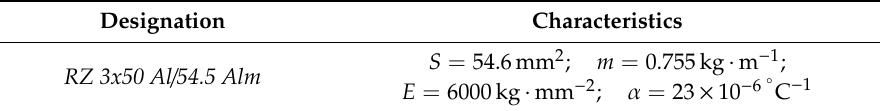
Table 1. Characteristics of cable RZ 3x50 Al / 54.6 Alm